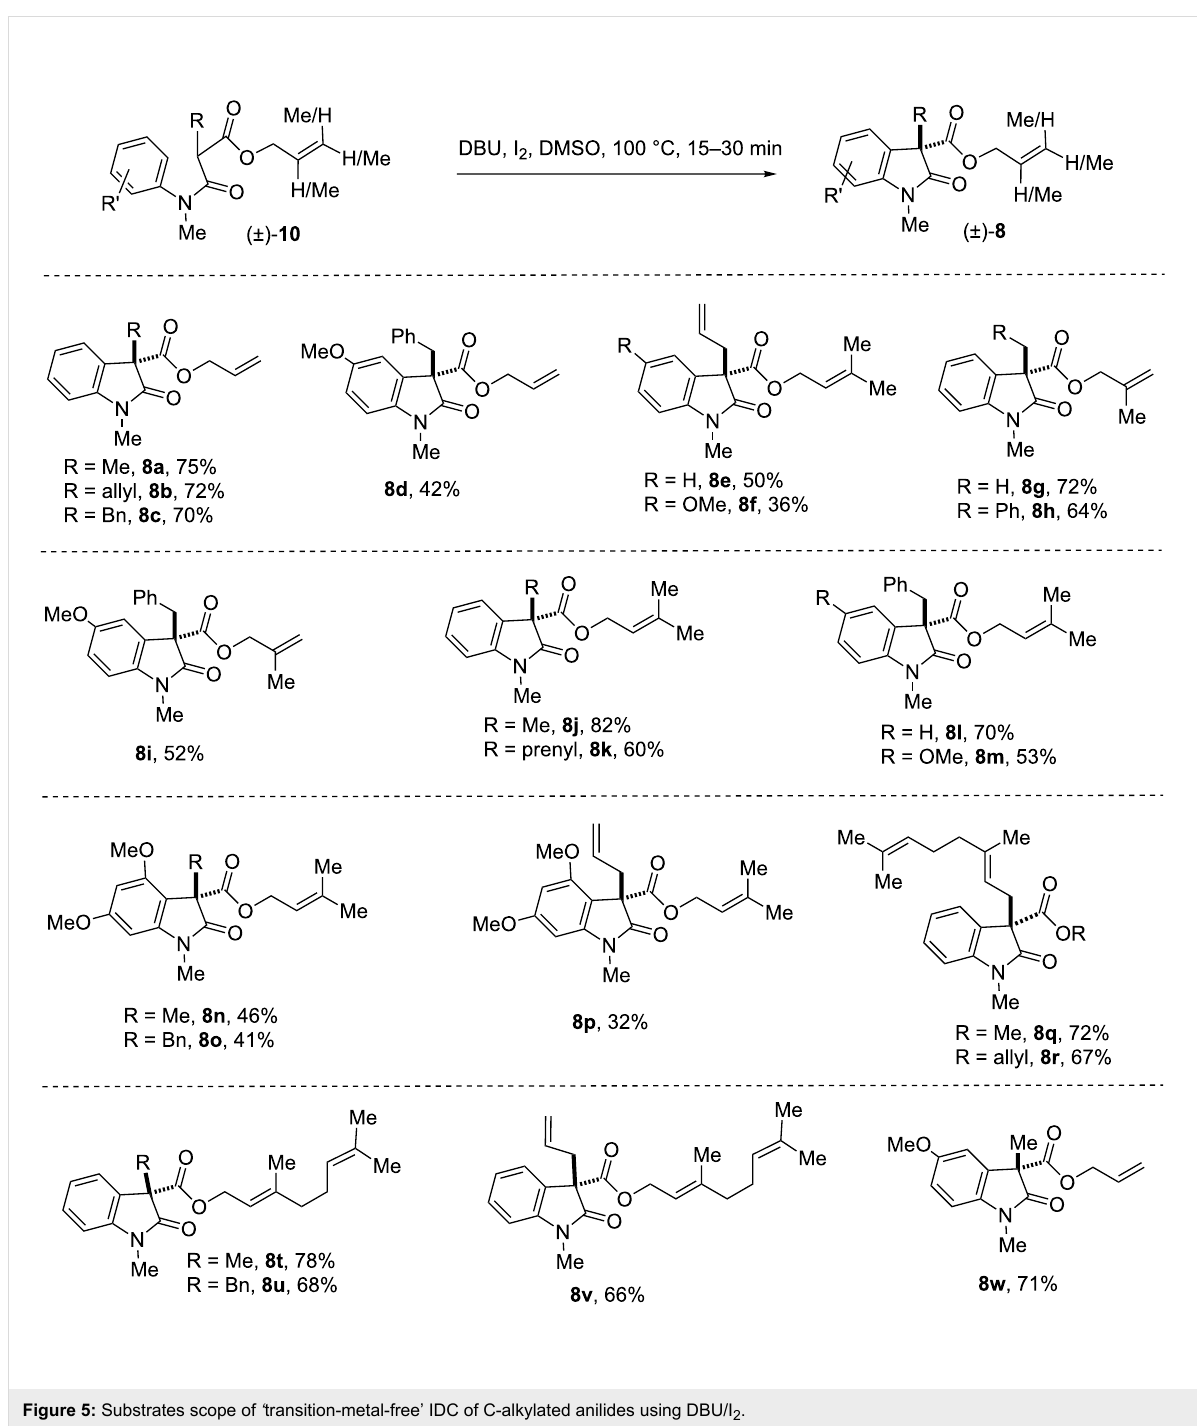
in the presence of 1.2 equivalents of KO t -Bu and I 2 followed by a double IDC on treatment with 1.2 equivalents of KO t -Bu